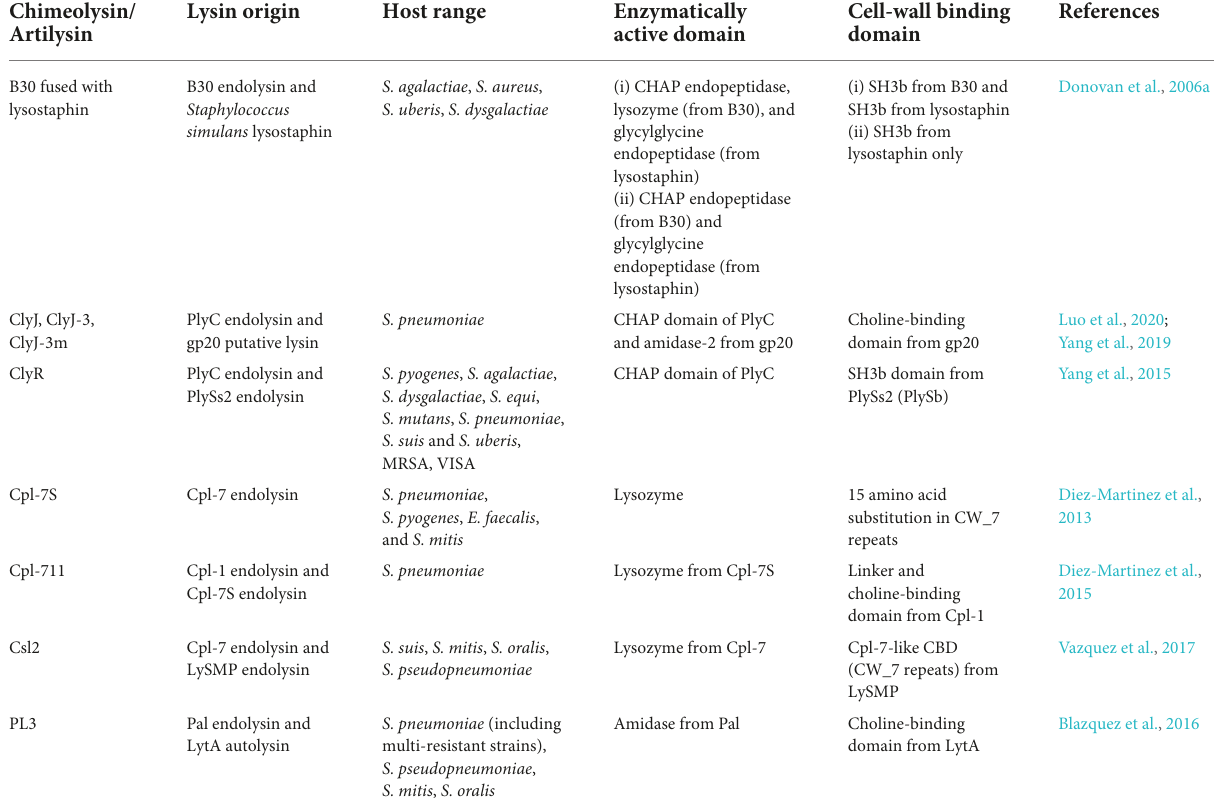
TABLE 2 List of engineered streptococcal endolysin (chimeolysin), including their origin, host range, enzymatically active domains (EADs), and cell wall-binding domains (CBDs). Chimeolysin/